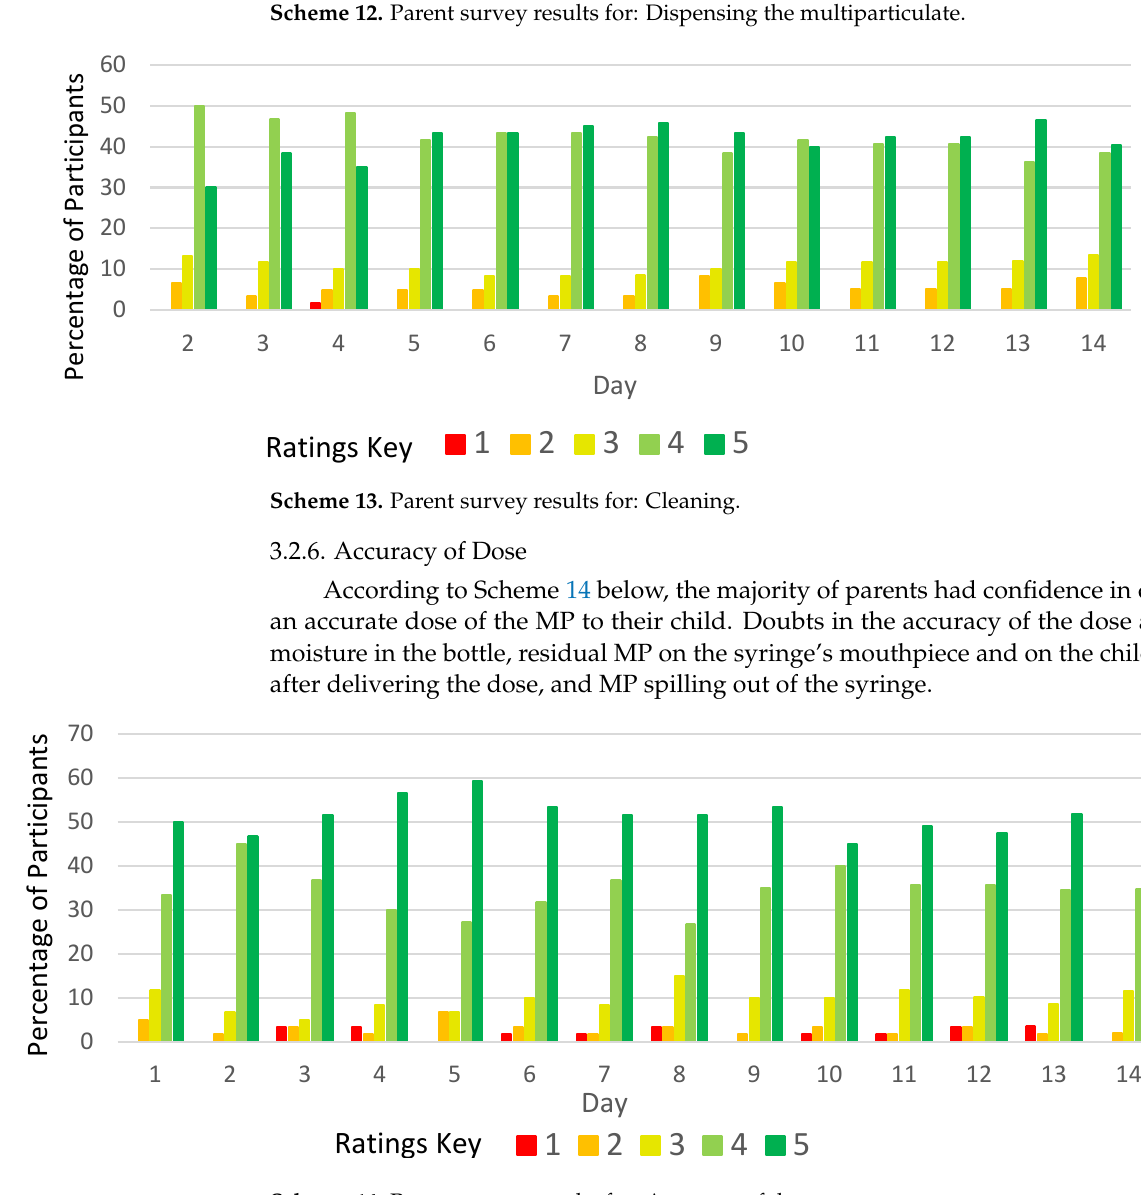
Scheme 14. Parent survey results for: Accuracy of dose